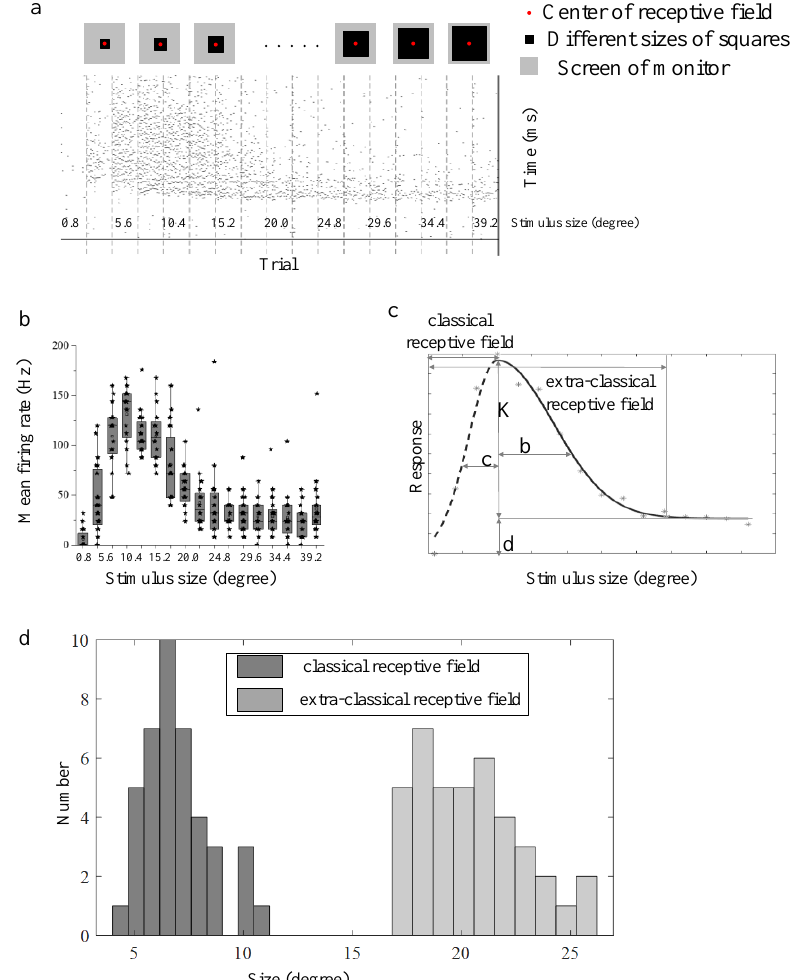
Figure 2. Size tuning curve of flashed squares stimuli as well as the estimated parameters. ( a ) Flashed squares (denoted by black square) of different sizes and the corresponding spike trains. The larger gray square indicates the scope of the screen. The middle red dot denotes the receptive field center; ( b ) the original mean firing rates of 20 repeats at an example recording site under each stimulus shown in ( a ). The horizontal line indicates the median of each group of data and the whiskers indicate the lowest and highest point within 1.5 × the interquartile ranges of the lower or upper quartile, respectively. Each black asterisk represents firing rates of a single trial. ( c ) The fitted size tuning curve (adjust-R 2 = 0.9462, left; adjust-R 2 = 0.8628, right) of data shown in ( b ) and explanation of each fitting parameter as well as the indication of estimated classical receptive field and extra-classical receptive field size. K is the amplitude of the Gaussian function. b and c are widths. d is offset of asymptotic response from spontaneous activity. ( d ) statistical histogram of receptive classical receptive field size and extra-classical receptive field of all recorded neurons ( n = 40).